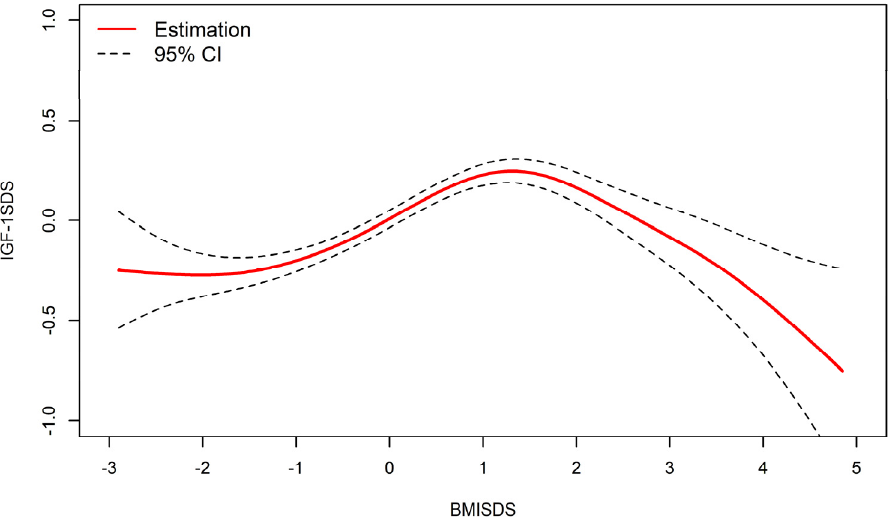
Figure 2. Nonlinear relationship between BMISDS and IGF-1SDS (adjusted for pubertal development and height standard deviation scores). BMISDS: body mass index standard deviation scores, IGF-1SDS: insulin-like growth factor-1standard deviation scores; CI: con fi dence intervals. R 2 = 0.416.